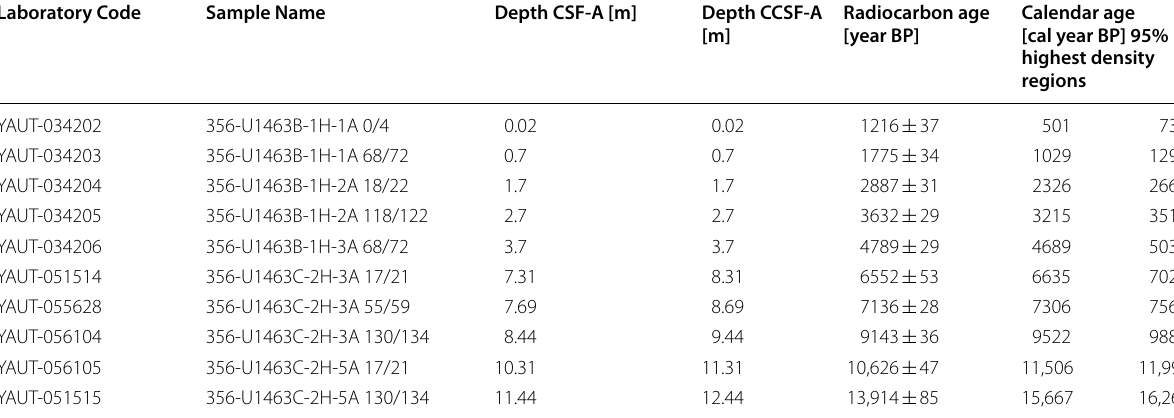
Calibration of calendar years was based on a Bayesian age modeling approach (Ramsey, 2009) using the Marine20 database (Heaton et al., 2020). Depth of individual samples is given as core depth below sea floor (CSF-A) and core composite depth below sea floor (CCSF-A), as defined by the IODP Depth Scale Terminology (IODP-MI 2011). Calendar ages are represented by the lower and upper boundary of the highest density region